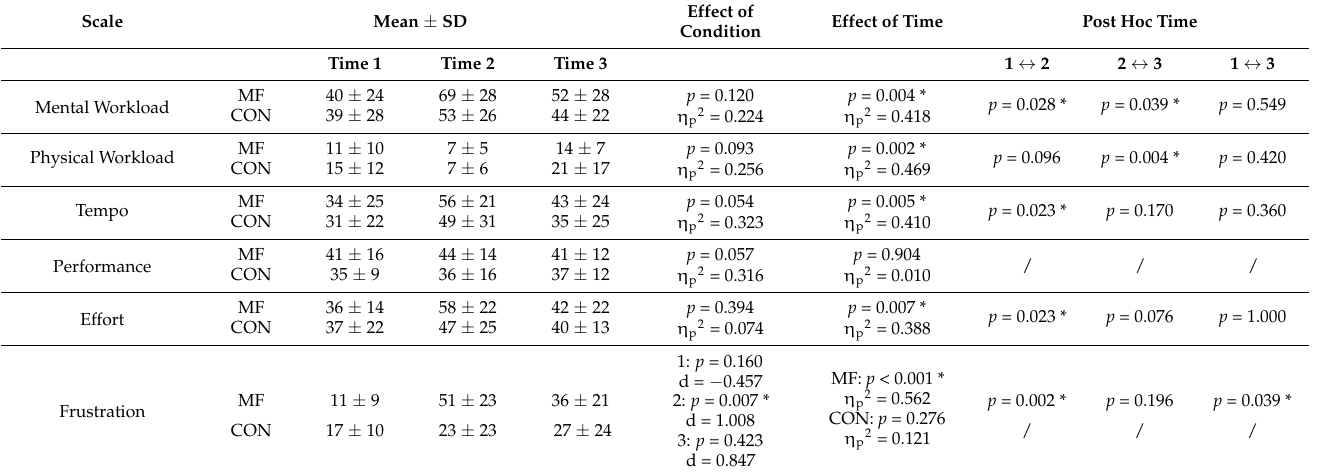
Table 2. Effects of condition and time on the different subscales of the